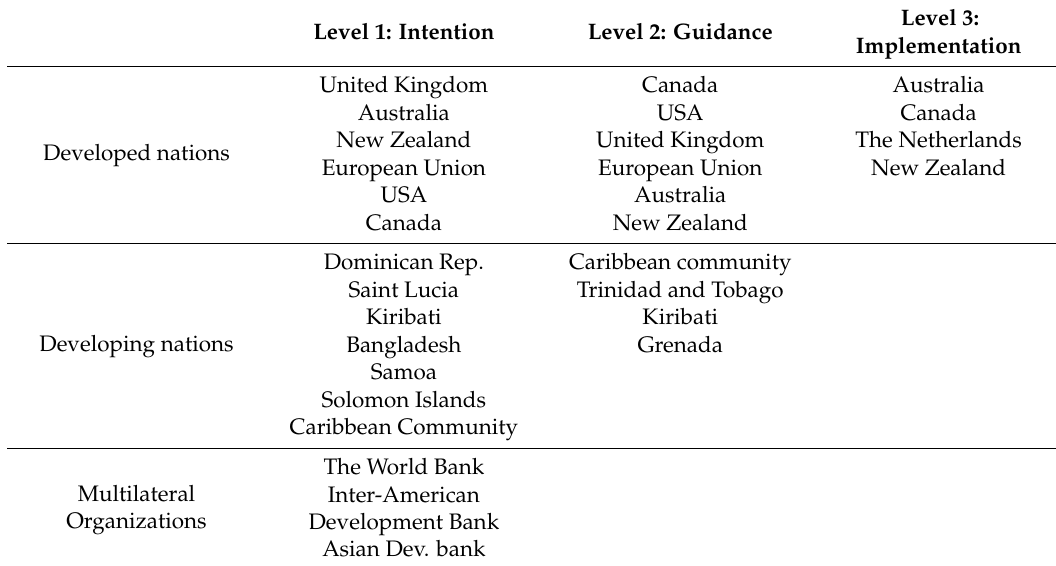
Table 1. An overview of climate change integration in Environmental Impact Assessment (EIA) in selected countries and